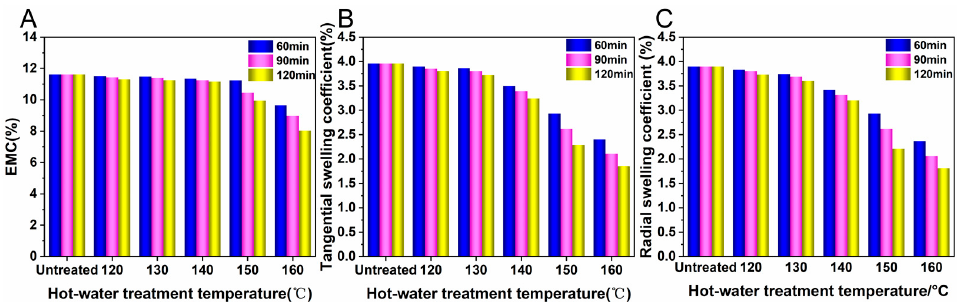
Figure 7. ( A ) Influence of different hydrothermal treatments on EMC; ( B ) Influence of different hy- drothermal treatments on tangential swelling coefficient; ( C ) Influence of different hydrothermal treatments on radial swelling